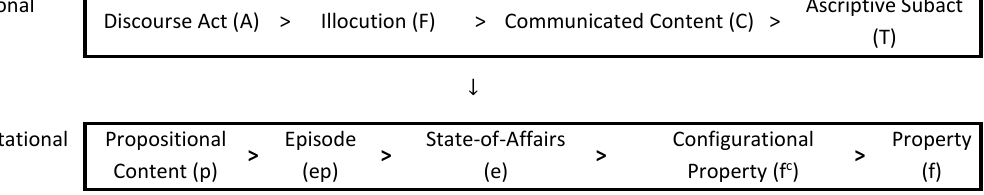
Figure 1. Scope relations in